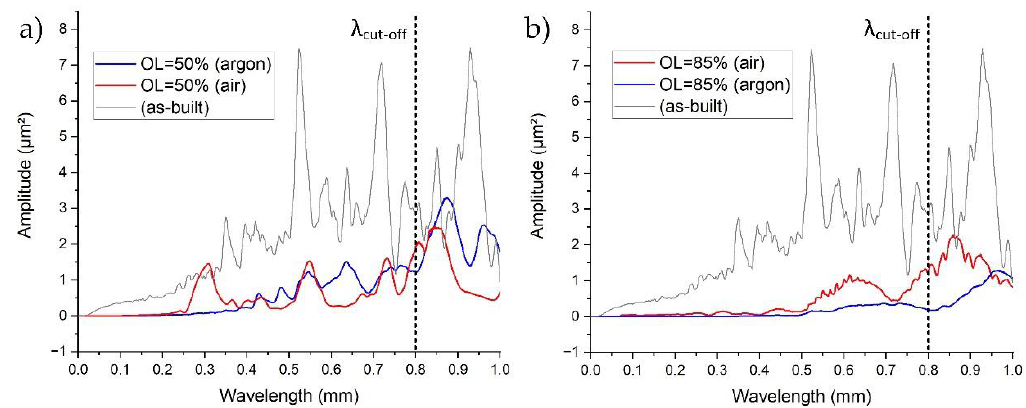
Figure 12. Power Spectral Density functions for the samples polished in argon and air with OL = 50% ( a ) and OL = 85% ( b ).